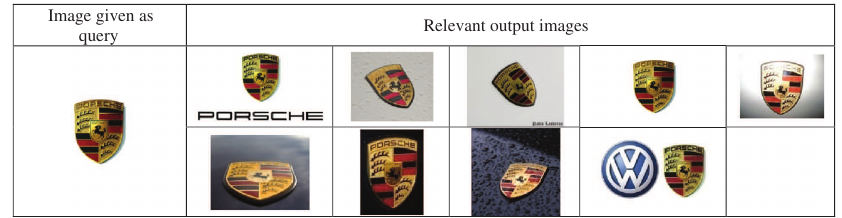
Table 3: Texture Similarity-Based Output Retrieved